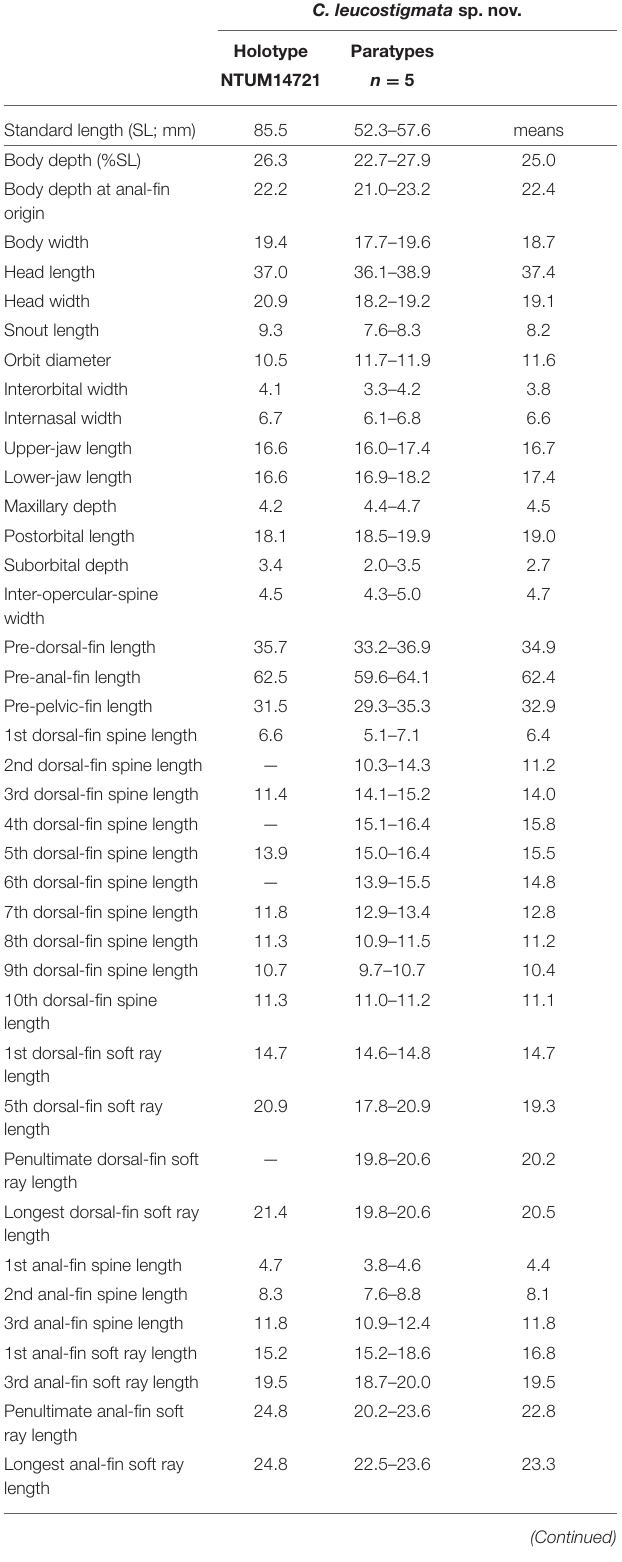
TABLE 5 | Mophometrics expressed as percentages of the standard length for Chelidoperca leucostigmata sp. nov. C. leucostigmata sp.